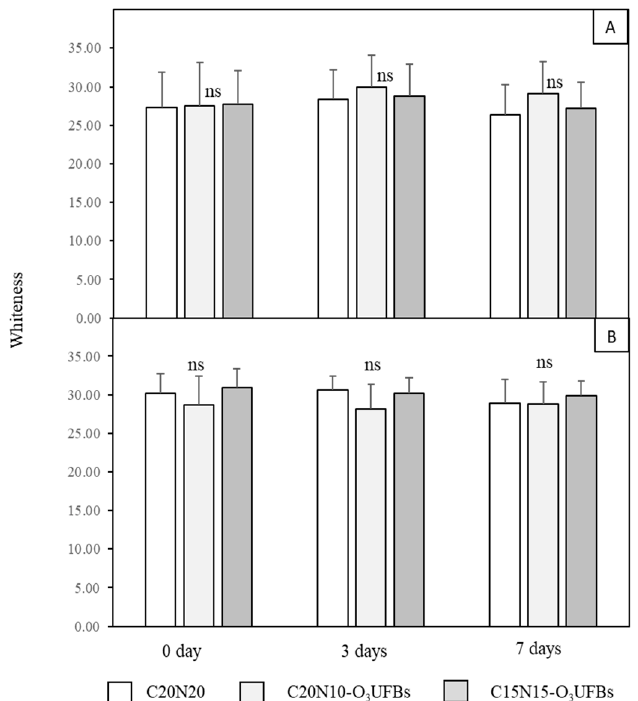
Figure 4. Mesocarp whiteness of trimmed coconuts dipped in C 20 N 10 -O 3 UFBs and C 15 N 15 -O 3 UFBs compared with C 20 N 20 when stored at 2 °C for 0 days (before storage) ( A ) and 30 days ( B ). After storage, all coconut fruits were transferred to 8–10 °C for 7 days, and the fruits’ whiteness was evaluated on days 0, 3, and 7. ns: not significantly different.